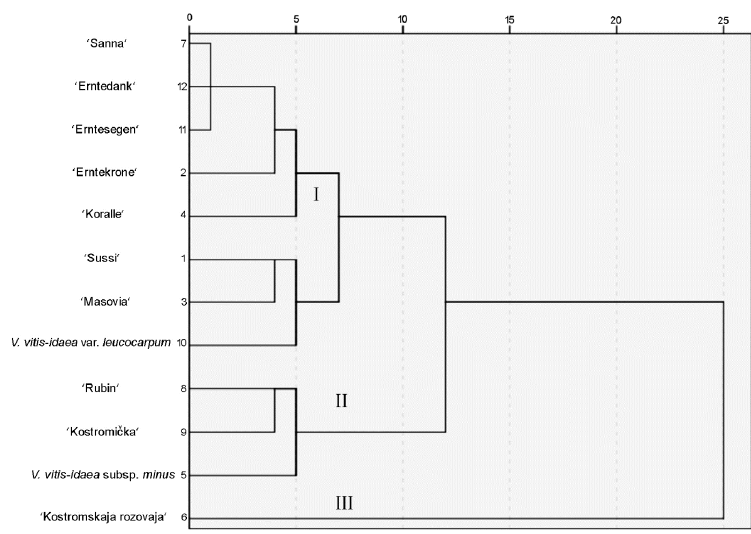
Figure 4. Dendrogram based on the amounts of phenolic compounds of lingonberry cultivars and lower taxa.